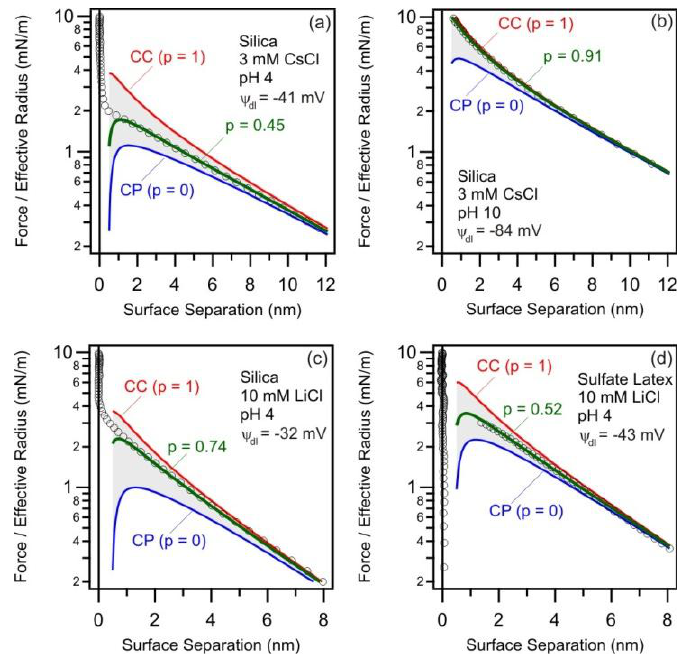
Figure 3. Normalized force profiles measured between ( a ) silica particles in 3 mM CsCl solution at pH 4, ( b ) silica particles in 3 mM CsCl solution at pH 10, ( c ) silica particles in 10 mM LiCl solution at pH 4, and ( d ) sulfate latex particles in 10 mM at pH 4. DLVO theory fits with constant regulation (CR) approximation are shown with full lines, whereby the values for the best fit for the diffuse layer potential ψ dl and the regulation parameter are indicated in the figures. The results for constant charge (CC, p = 1) and constant potential (CP, p = 0) are also shown. The region between CP and CC is